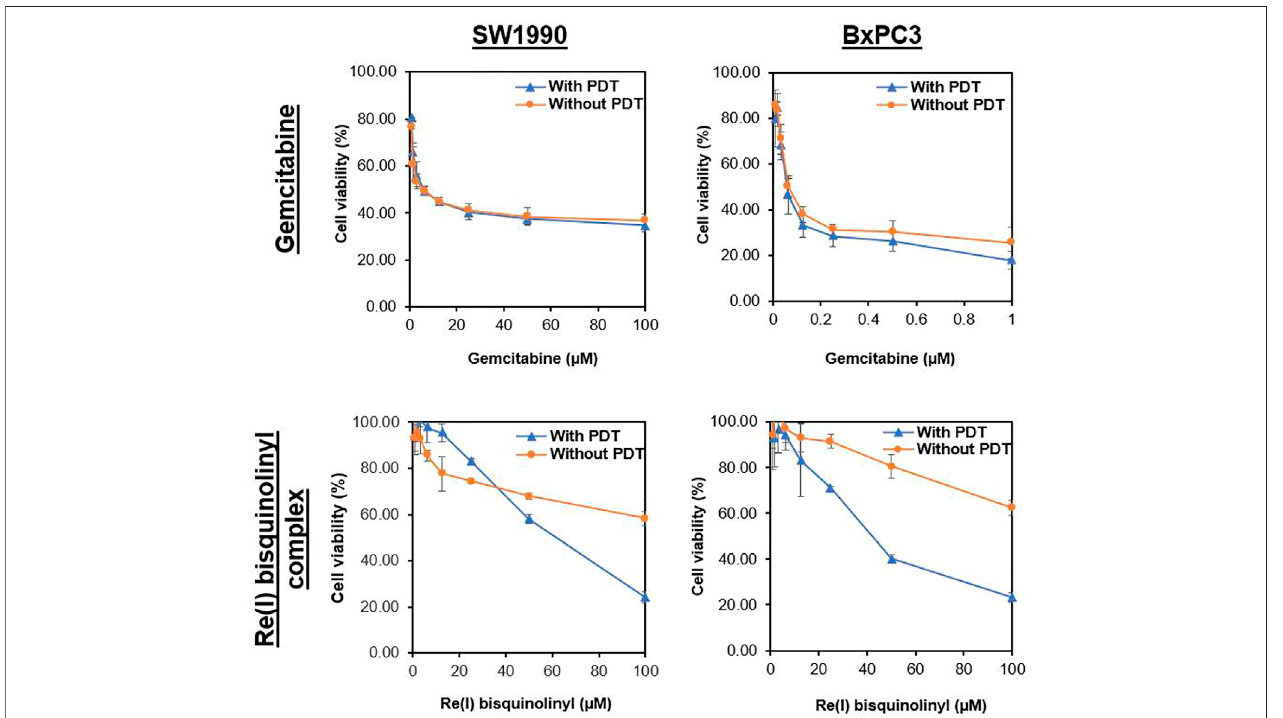
FIGURE 2 | Dose response curves of gemcitabine and Re(I) bisquinolinyl complex in pancreatic cancer cells.